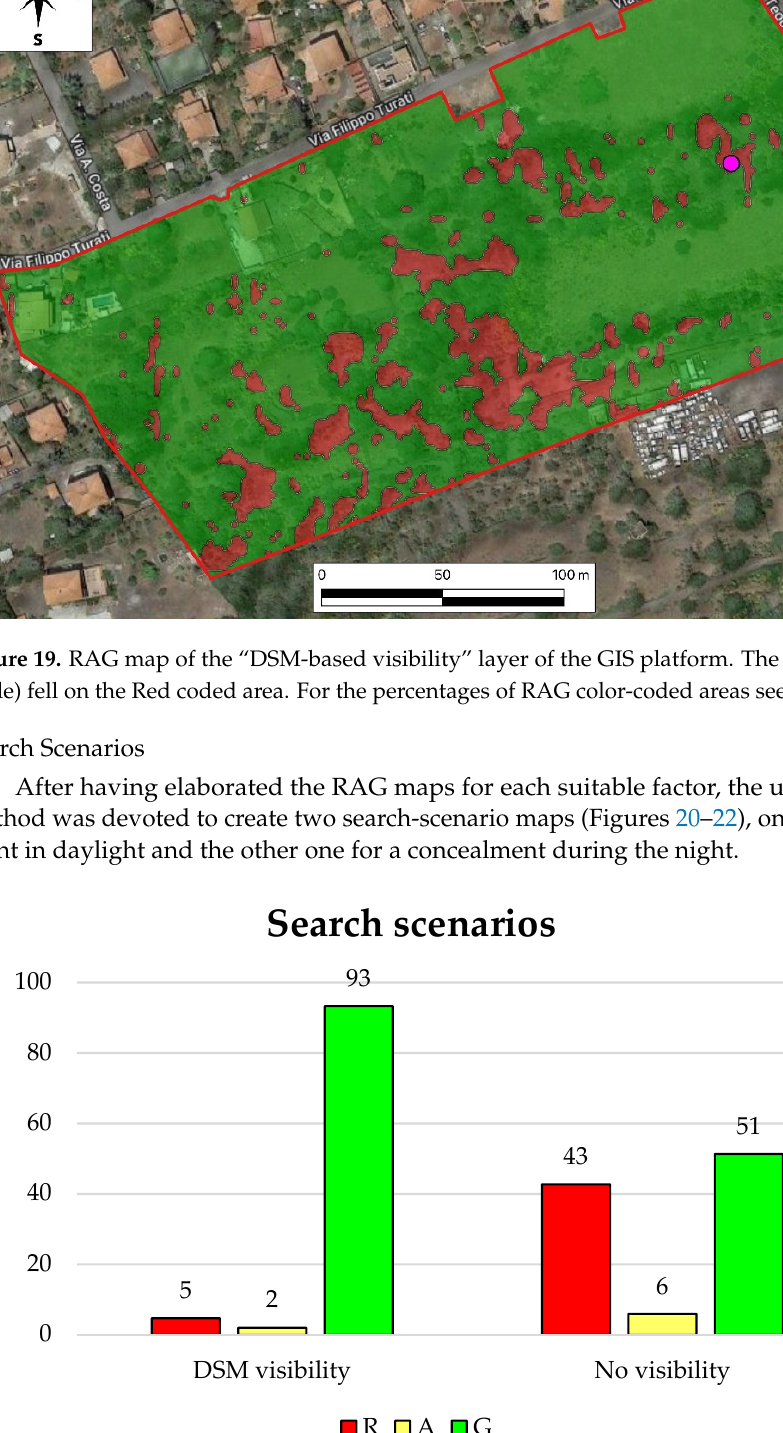
Figure 18. Localization of the viewpoints used for the view shed analysis.